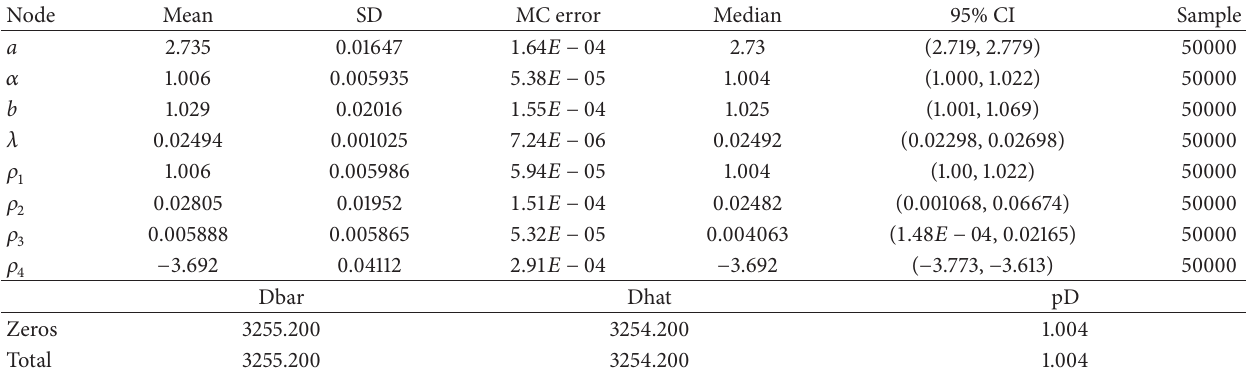
Table 6: Summary results of the posterior parameters in the case of BGE for Black Hispanic females breast cancer patients ( 𝑛 = 298 ). Node